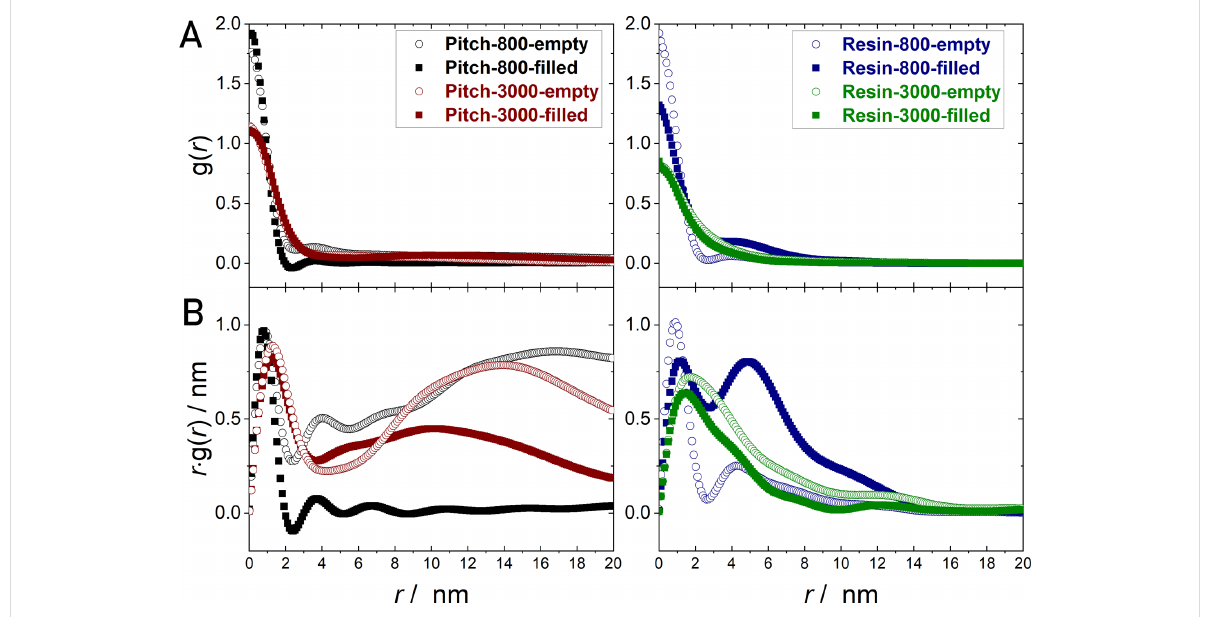
Figure 4: SANS raw data (A) and CLD analysis (B) for the four resin- and pitch-based carbon materials, treated at 800 and 3000 °C. For all samples, SANS analysis was performed on evacuated samples (hollow symbols), as well as under a maximum load of deuterated p -xylene (filled symbols). All samples exhibit a Porod-asymptote ( s − 4 ) at large s (modulus of the scattering vector), proving an almost ideal two-phase system (pore–carbon) with sharp interfacial boundaries on the nanometer scale.